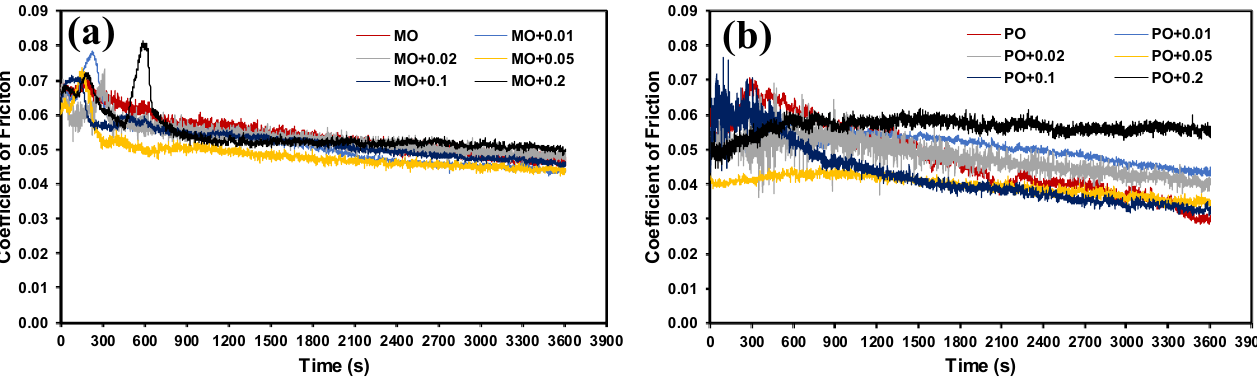
0.000.010.020.030.040.050.060.070.080.09 Figure 3. Coefficient of friction curves over the testing time: ( a ) MO oil samples and ( b ) PO oil samples. This can be attributed to the addition of NPs, which increased the viscosity of nanolubricant, thus a thick and stable tribofilm formed and provided better surface pro- tection. An increase in the concentration of NPs increases the viscosity of nanolubricants.